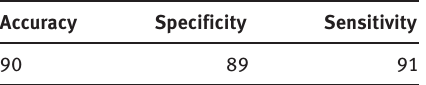
Table 1: Comparison of Performance Maintenance for ANFIS Classification.